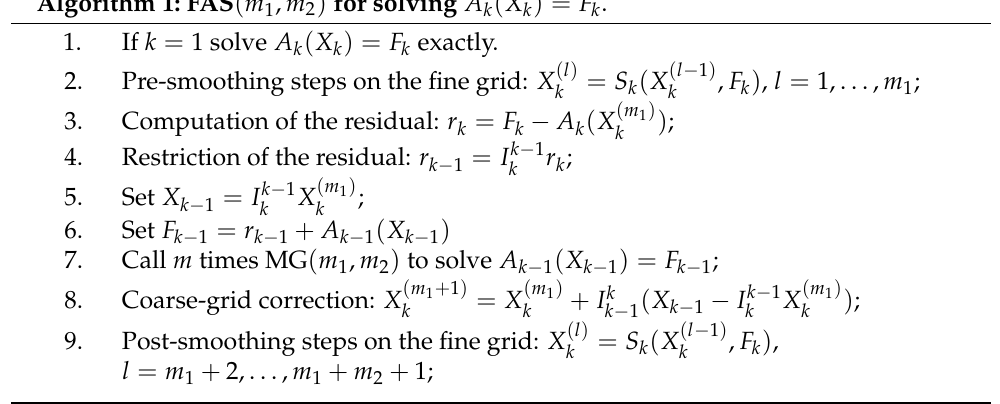
Algorithm 1: FAS ( m 1 , m 2 ) for solving A k ( X k ) = F k .